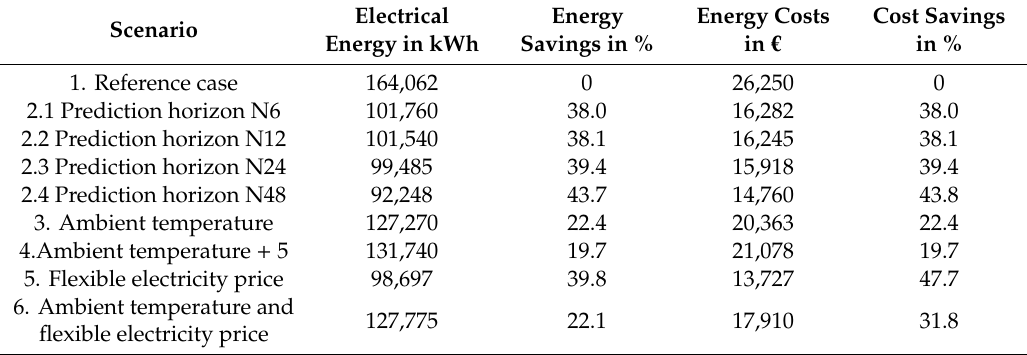
Table 3. Overview of optimization